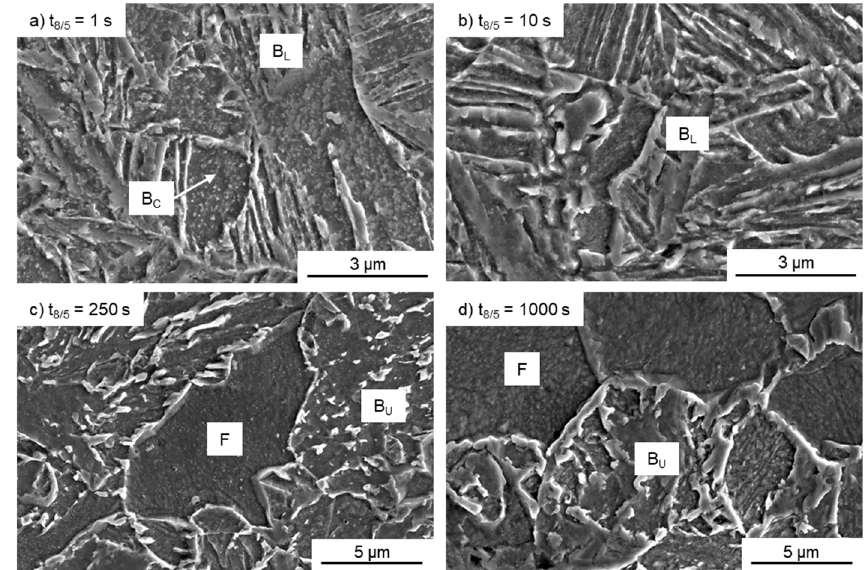
Figure 8. SEM images of the microstructure of the dilatometer specimens heated to 1000 °C peak temperature and cooled with different t 8/5 -times of ( a ) 1 s; ( b ) 10 s; ( c ) 250 s and ( d ) 1000 s showing lower bainite (B L ), coalesced bainite (B C ), upper bainite (B U ) and ferrite (F).